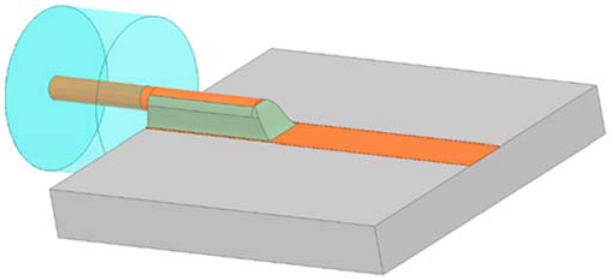
Figure 5. Overall structure of the solder joint of the lead wire interconnection.